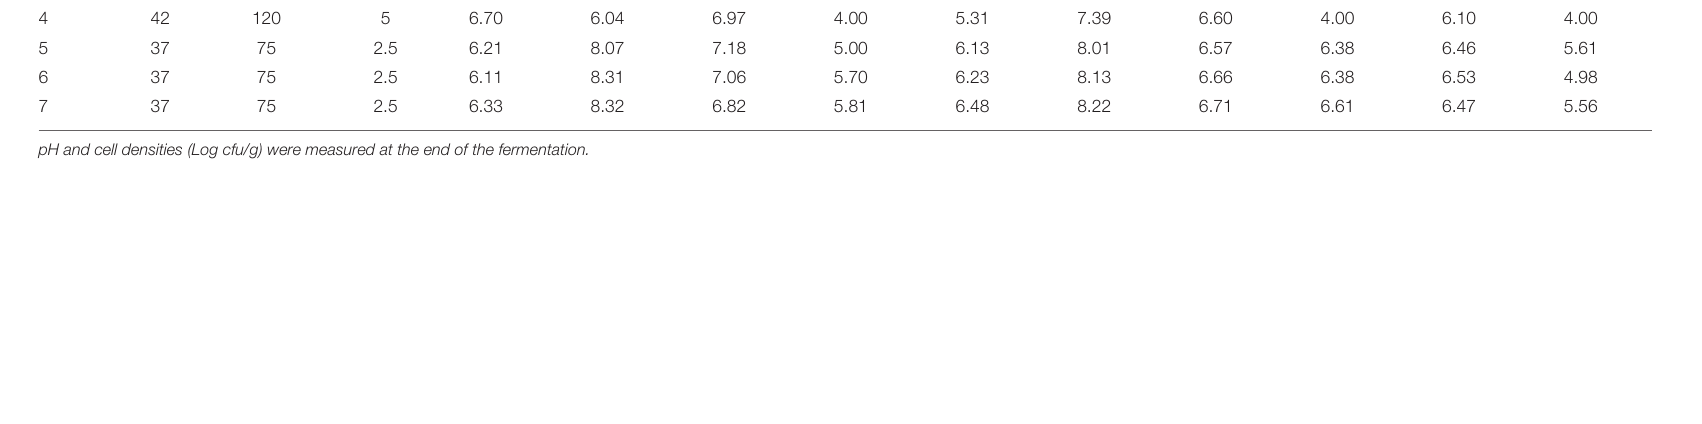
TABLE 5 | Experimental condition for microorganism with an optimum at 30 ◦ C in vanilla beans with seeds. Exp